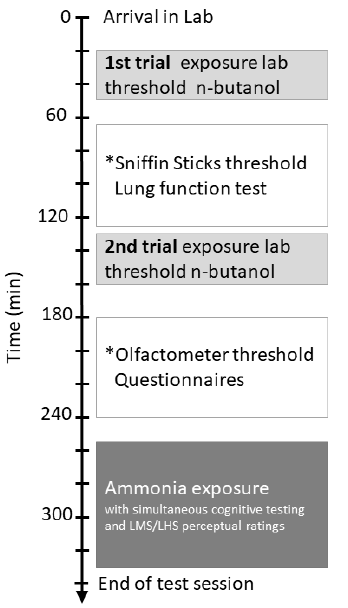
Figure 1. Study procedure. * blocks were switched randomly for half of the participants. LMS = la- beled magnitude scale, LHS = labeled hedonic scale. labeled magnitude scale, LHS = labeled hedonic